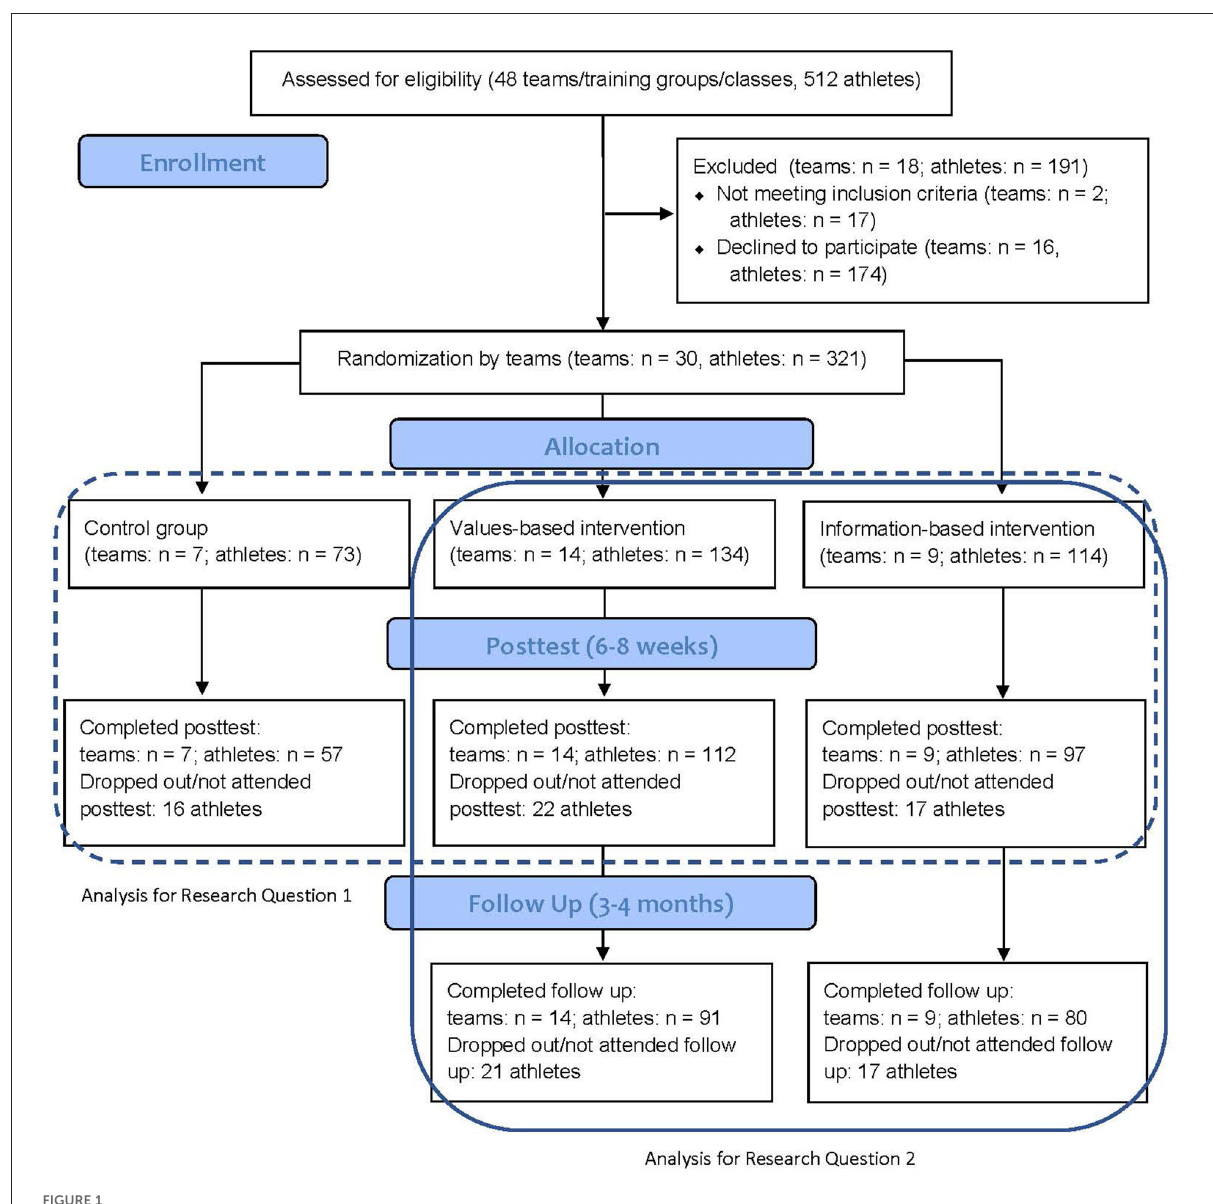
FIGURE1 CONSORT participant